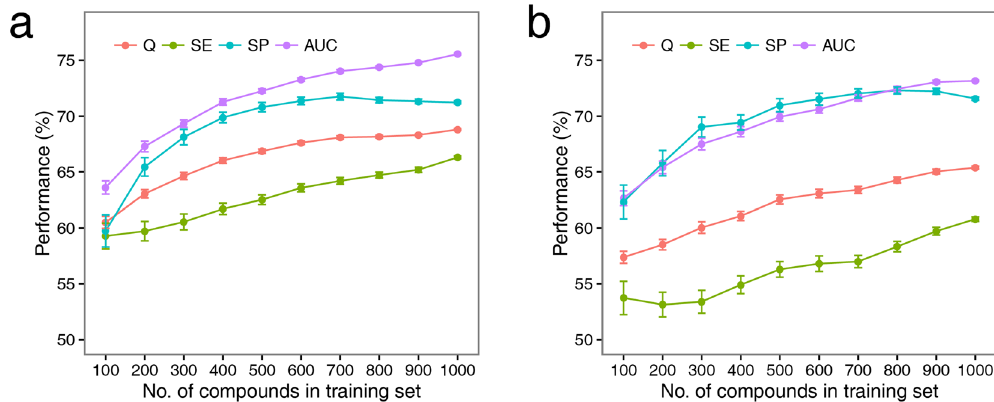
Figure 3. Performance on five-fold cross-validation ( a ) and external validation ( b ) as a function of number of compounds in training set for RF ensemble models. The performance values are represented as means and standard